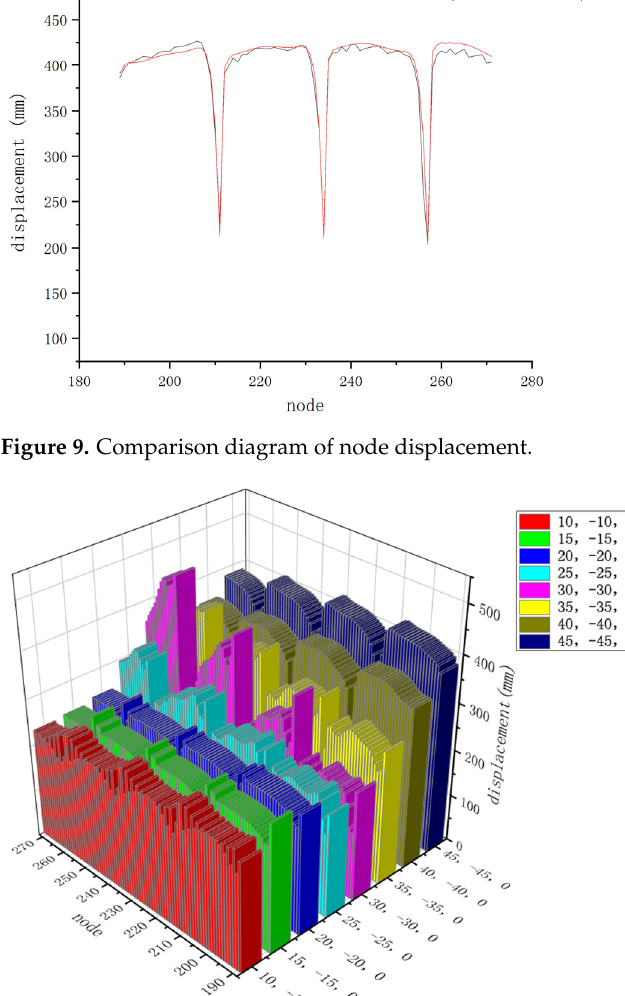
Figure 10. Node displacement diagrams at different angles.